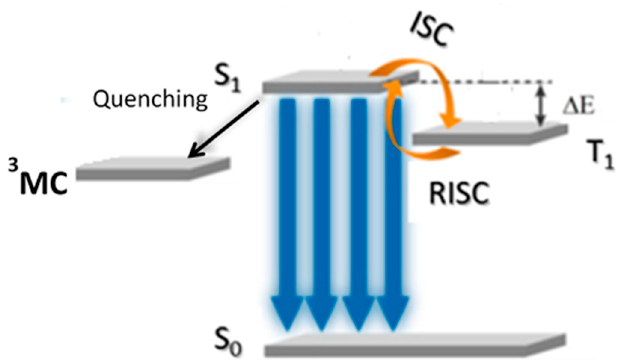
centred (MC) Figure 2. Schematic representation of the quenching introduced by the presence of low lying metal centred (MC) states.